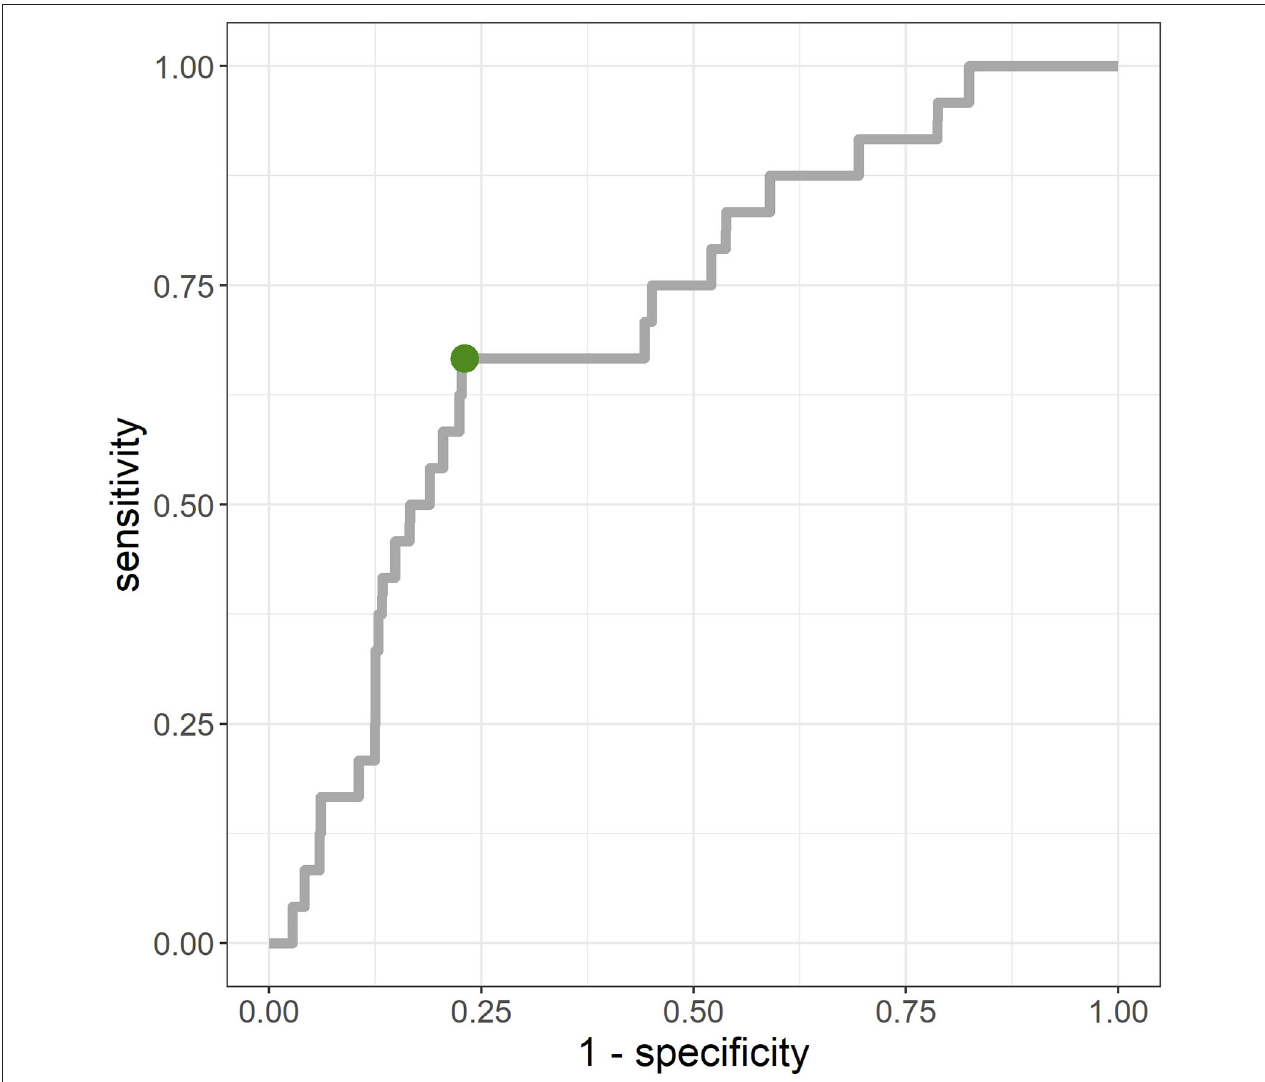
FIGURE 3 | Receiver-operating-characteristic (ROC) for merged validation data created by 10-fold cross validation. Area-under-the-curve (AUC) = 0.711. The point closest to the top left (0,1) was (0.23, 0.67), and the corresponding cut-off value was 0.9%.